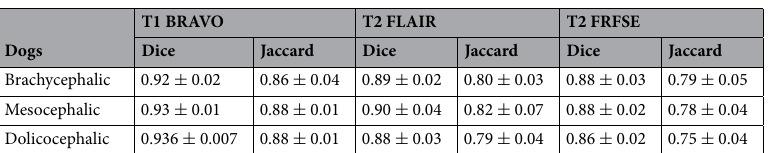
Table 5. Dogs cohort results of VIBE, sorted by cranial conformations (brachycephalic, mesocephalic, dolichocephalic). Comparison of the mean and standard deviation results of both the Dice similarity coefficient and Jaccard index for three different sequences (T1 BRAVO, T2 FLAIR and T2 FRFSE).